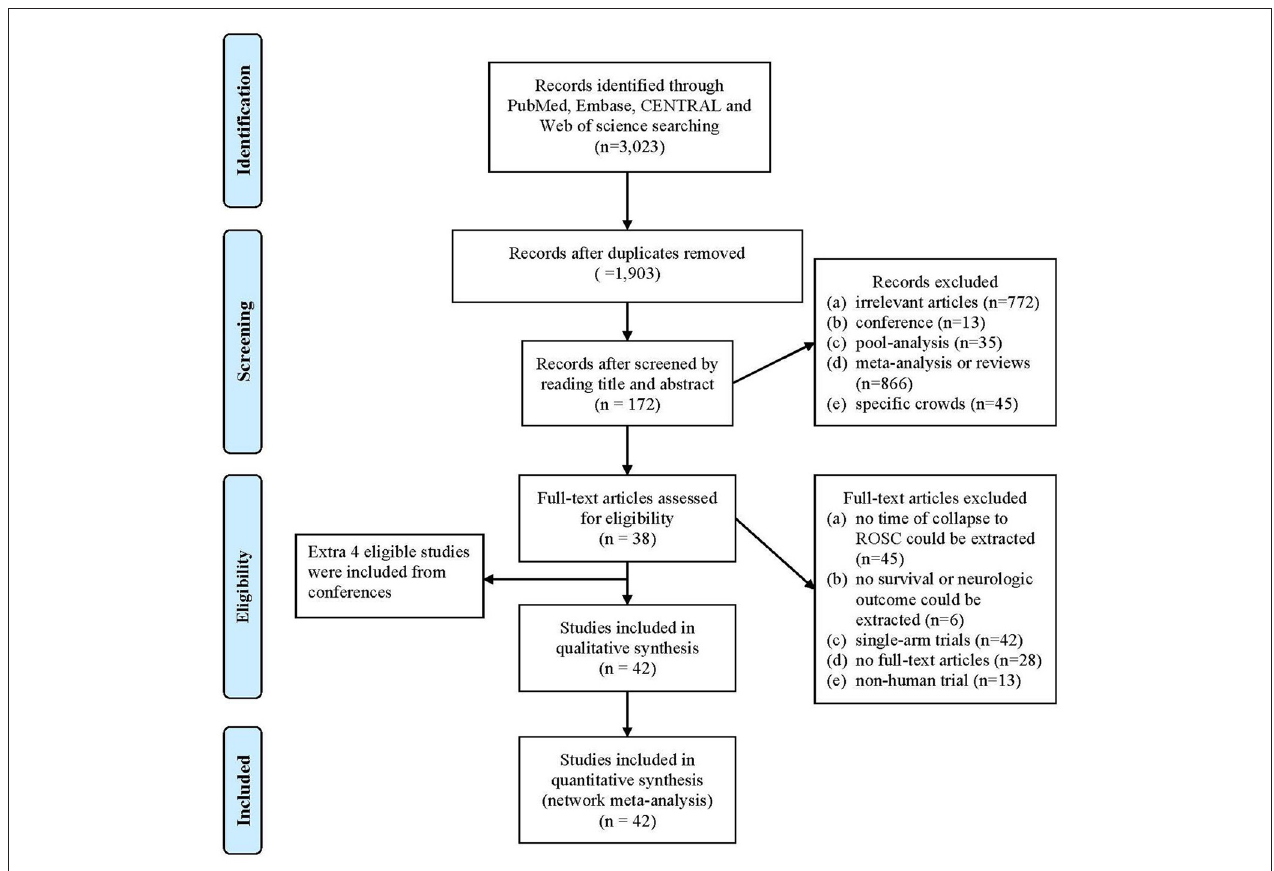
FIGURE 1 | Flow diagram according to PRISMA